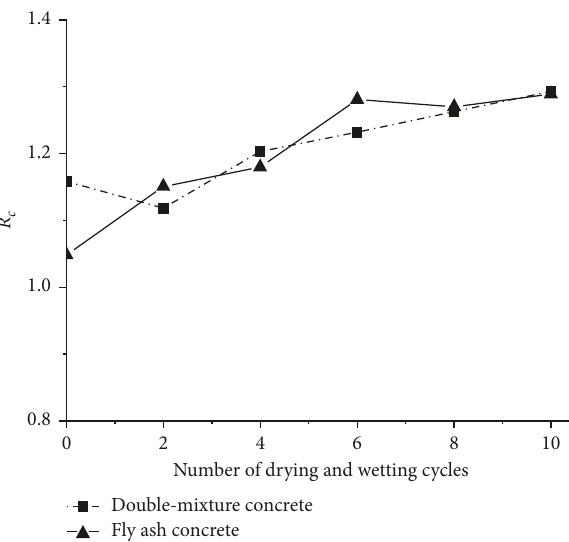
Figure 7: Relative compressive strength ratio of modified concrete corroded by (NH 4 ) 2 SO 4 solution.